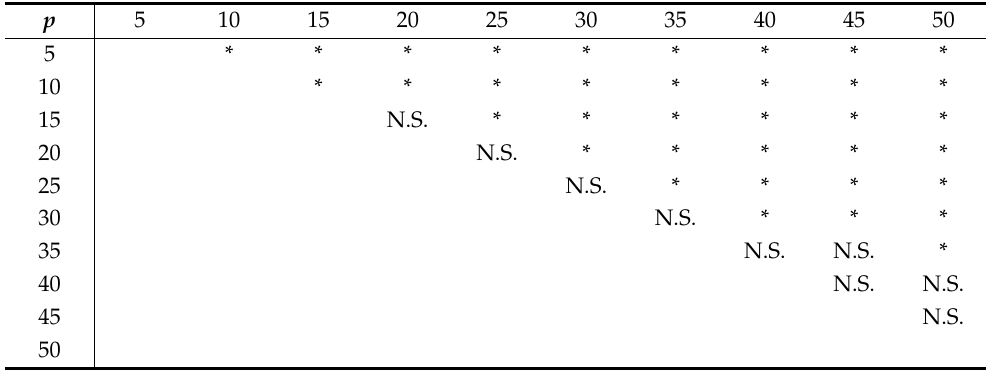
Table 8. Statistical significance in dryness perception for samples with a w value of 25 µ m for various p values. * Significance level < 0.05. N.S. means not significant.